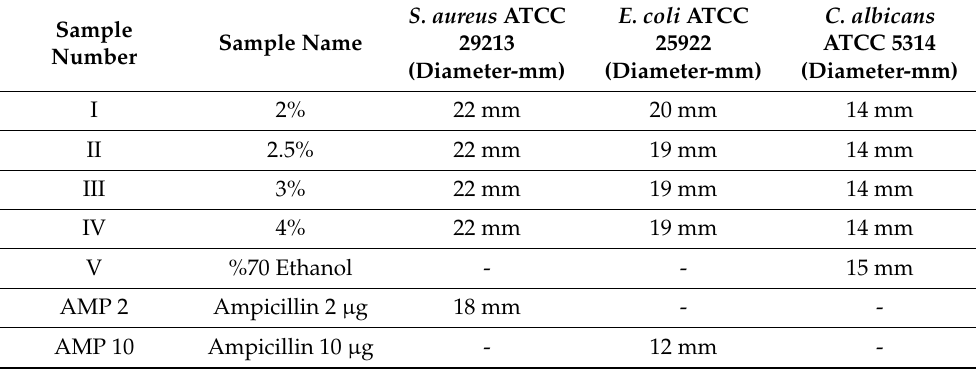
Table 2. As a result of the disc diffusion (antimicrobial test) test, the inhibition zones created by the zinc oxide nanoparticles were measured in mm and listed in the table. These inhibition zones were created by adding ginger extract to the prepared zinc oxide solution at various rates (2, 2.5, 3, and